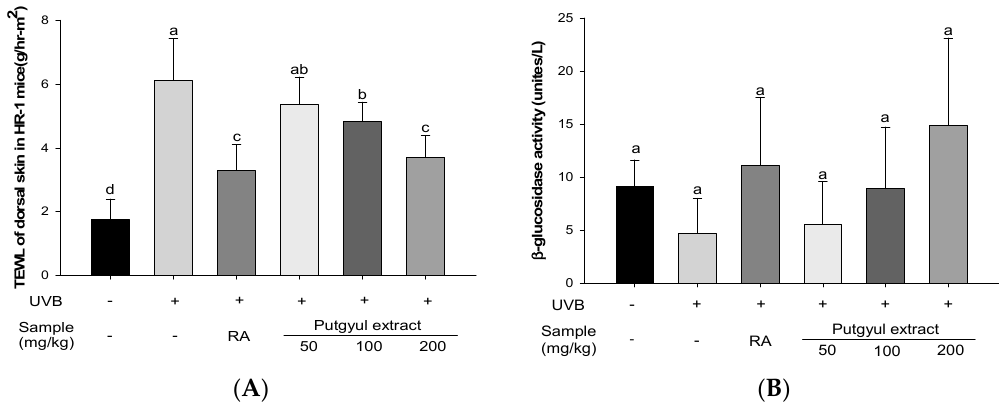
Figure 5. Moisturizing effect of putgyul extracts in UVB-induced hairless mice. ( A ) Transepidermal water loss (TEWL) of dorsal skin; ( B ) β - glucosidase activity. a–c All values are presented as mean ± standard deviation. Bars with different letters indicate statistically significant differences among the groups at p < 0.05 by one-way ANOVA.